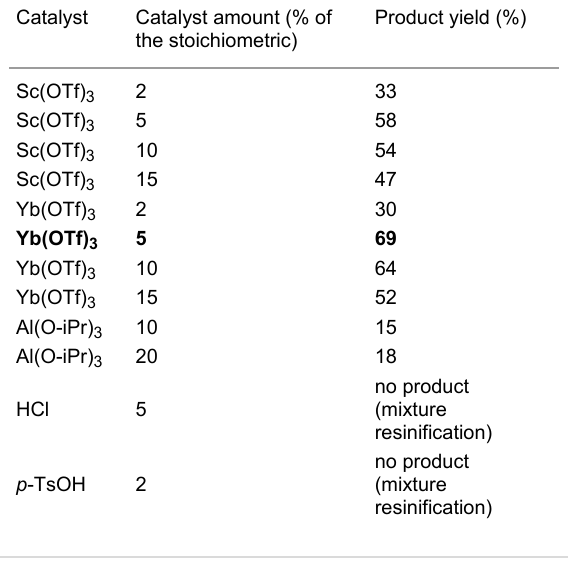
Table 1: Optimization of the reaction conditions for obtaining com- pound 5a . Catalyst